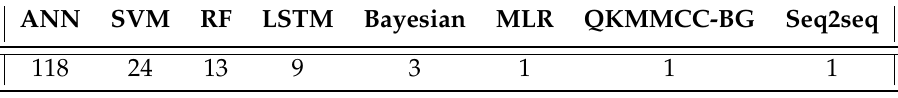
Figure 4. Most widely used algorithms and Machine Learning